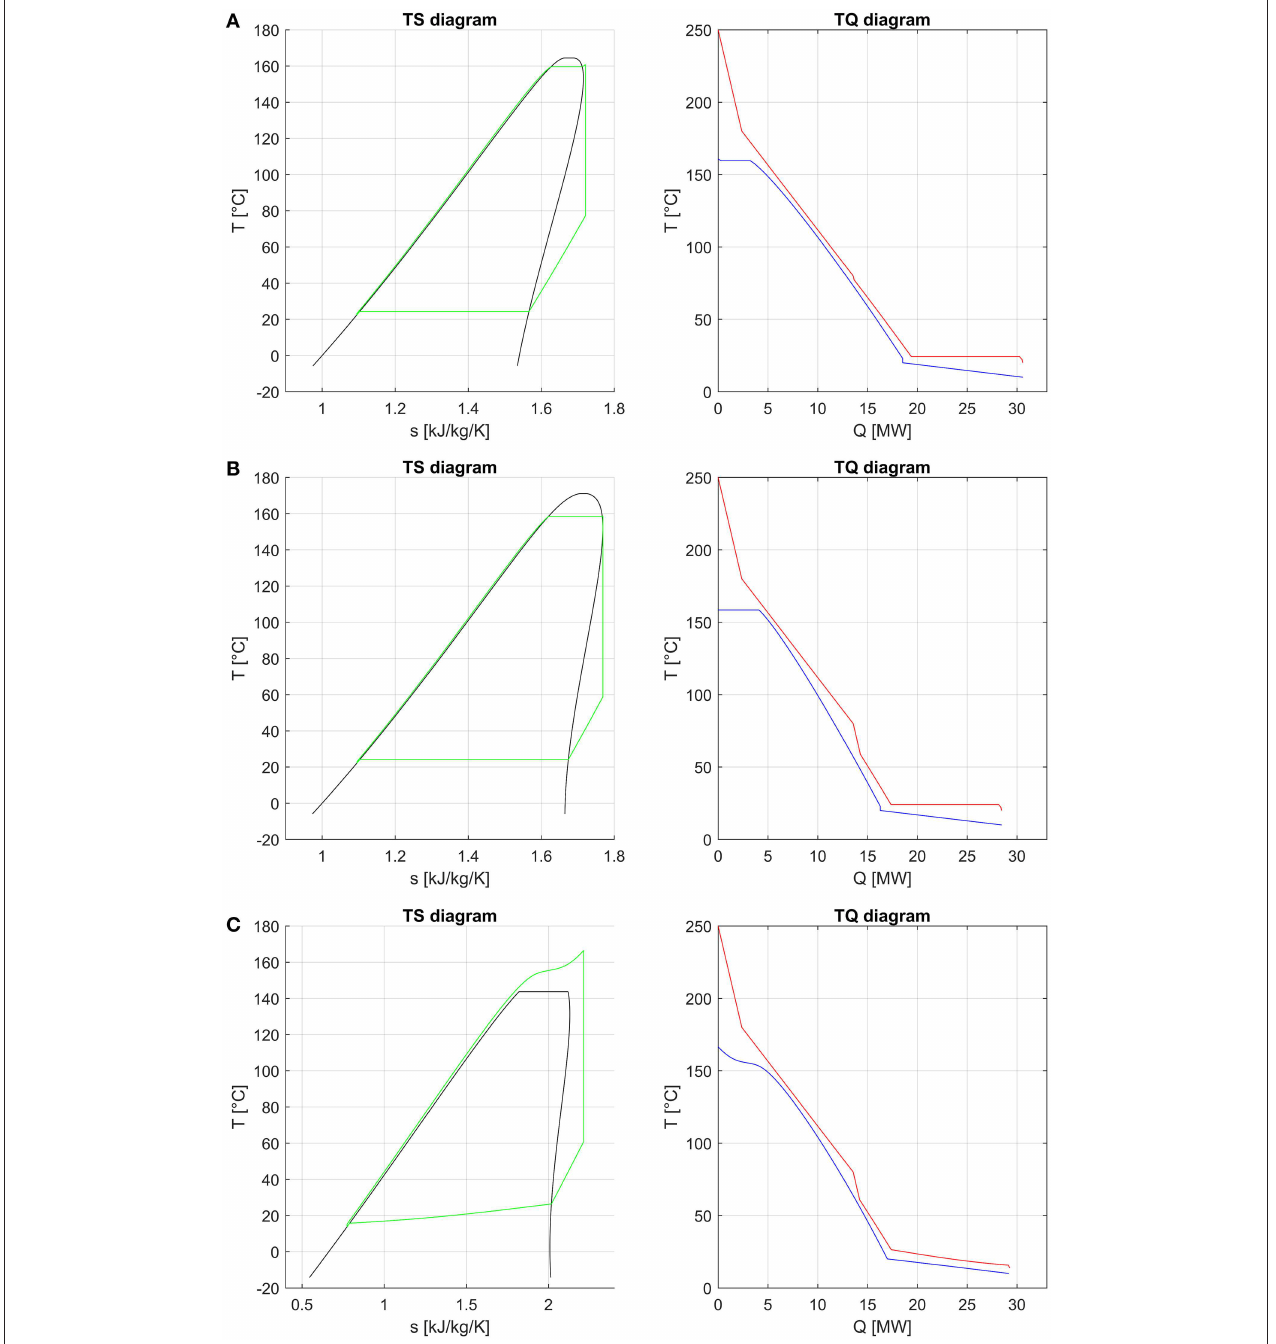
FIGURE 4 | Temperature–entropy (T–s) diagram and composite curves (T–Q diagrams) of the optimized organic Rankine cycle (ORC) employing RE347mcc (A) , R1336mzz (B) , and the binary zeotropic mixture isobutane/isopentane (0.66/0.34) (C) . The saturation curve of this last one could not be computed in a reliable way in the region close to the critical temperature due to convergence issues of the flash